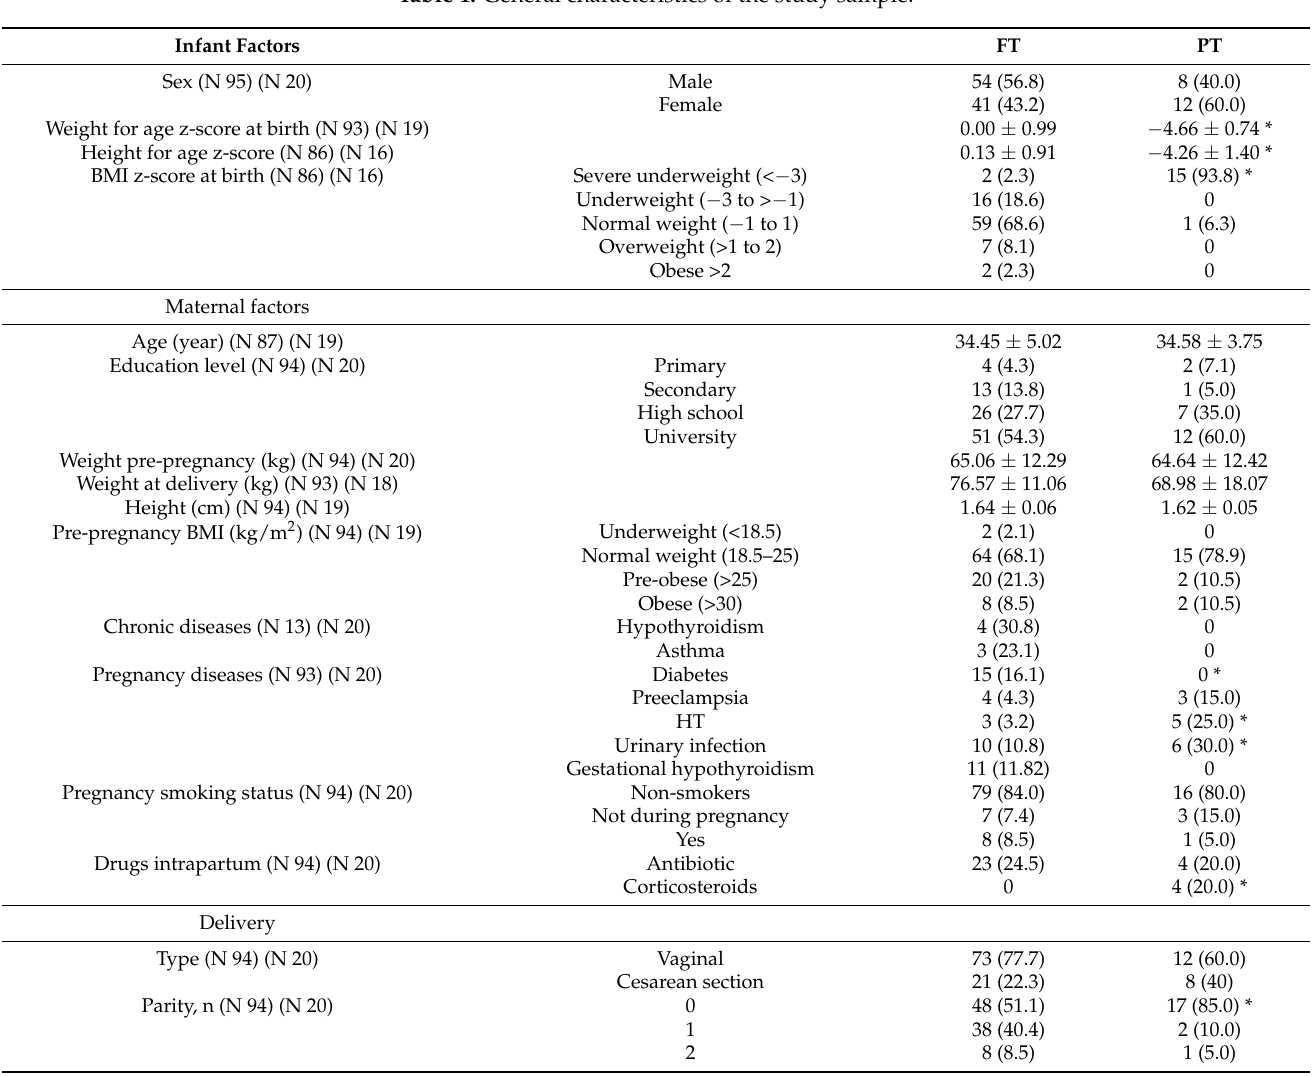
Table 1. General characteristics of the study